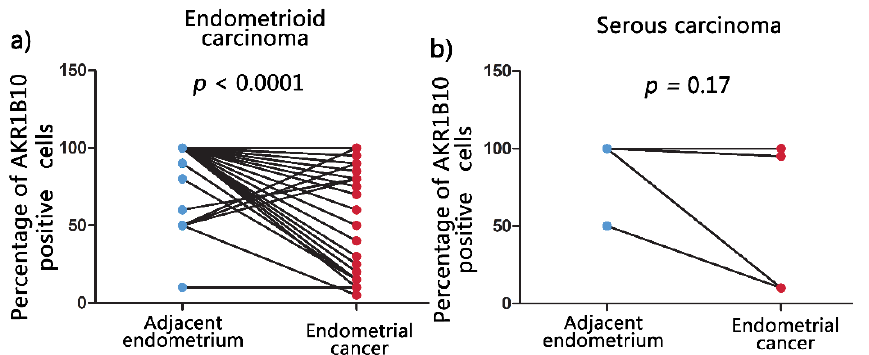
Figure 5. AKR1B10 immunohistochemical expression in EC and the adjacent non-neoplastic endo- metrial tissue. Before and after graphs show the expression of AKR1B1 in endometrial cancer tis- sue and its paired adjacent non-neoplastic endometrial tissue. ( a ) Adjacent non-neoplastic endo- metrial tissue ( n = 61, mean = 94.1, median = 100, IQR = 0) compared to endometrioid EC ( n = 61, mean = 65.5, median = 80.0, IQR = 75.0). ( b ) Adjacent non-neoplastic endometrial tissue ( n = 9, mean = 94.4, median = 100, IQR = 0) compared to serous EC ( n = 9, mean = 78.9, median = 100, IQR = 47.5). AKR1B10: aldo-keto reductase family 1 member B10; IQR: interquartile range; N : number of patients.